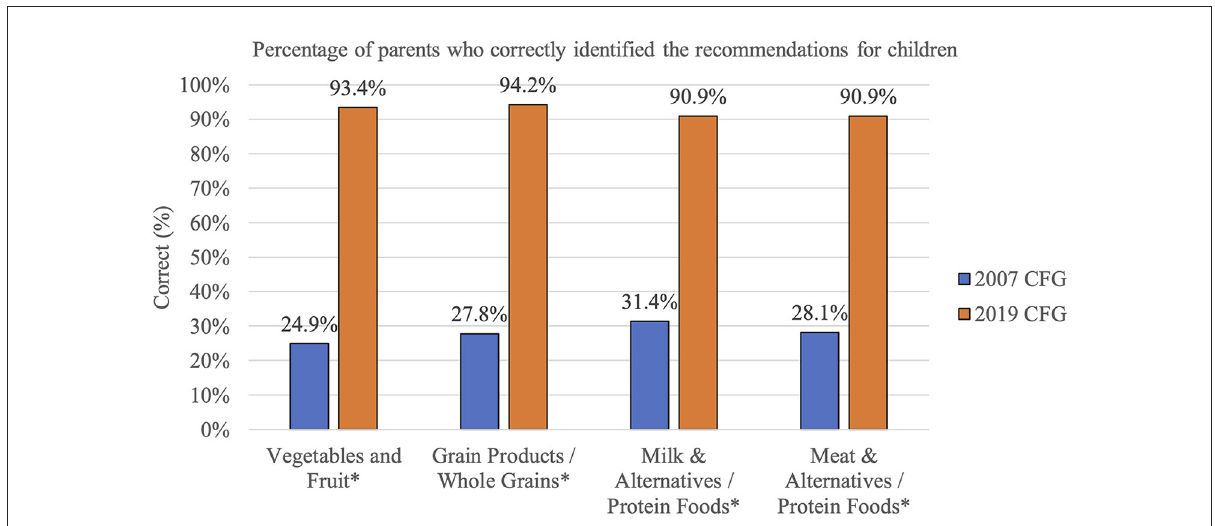
FIGURE2 Knowledge of children CFG food groups serving size (2007) and proportion (2019) recommendations among parents from the GFHS. * Asterisks indicates a statistically significant difference, p <